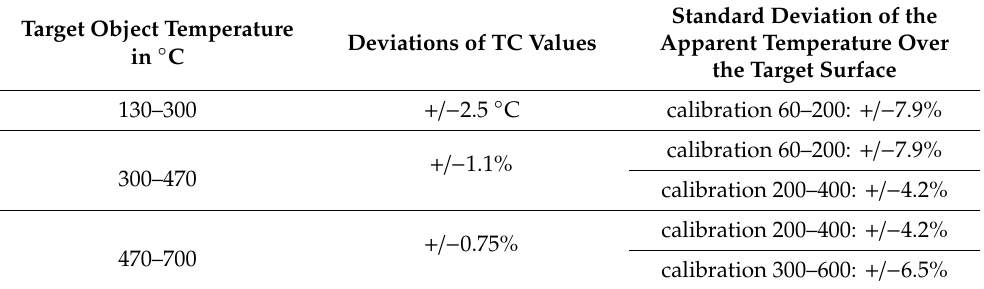
Table 2. Measurement uncertainties of temperature